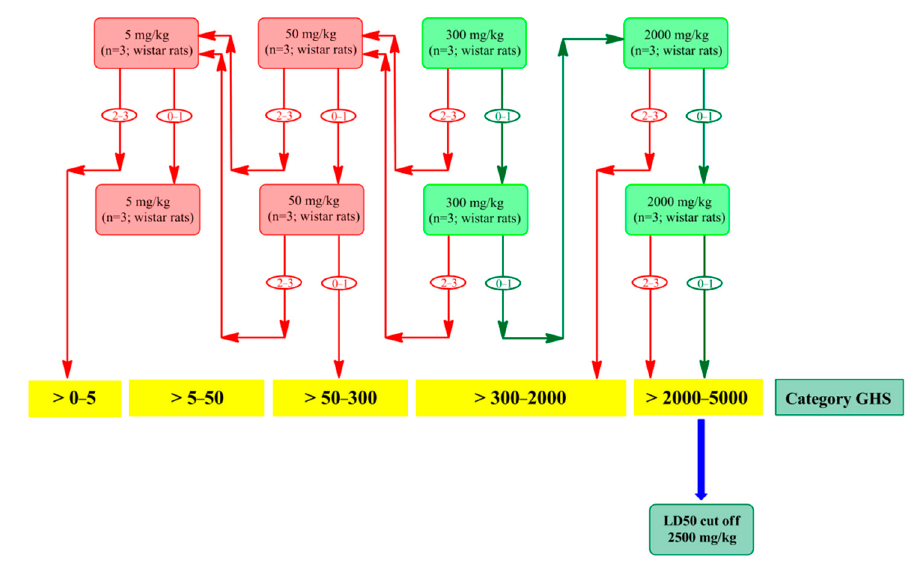
Figure 2. Treatment schedule procedure, as per the OECD’s 423 guidelines, with a starting dose of 300 mg/kg body weight; 0, 1, 2, 3 represents the number of moribund or dead animals at each